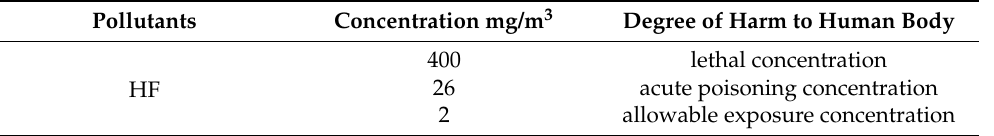
Table 1. HF environmental threshold.